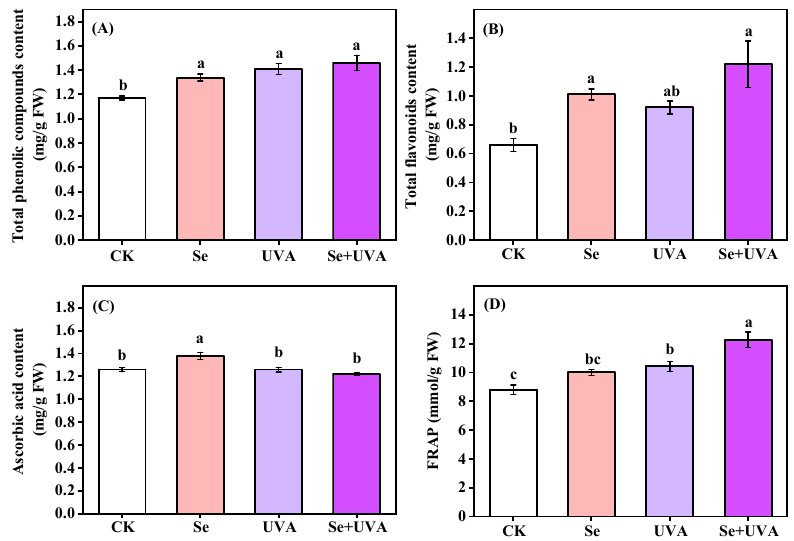
Figure 4. The contents of total phenolic compounds ( A ), total flavonoids ( B ), ascorbic acid ( C ), and FRAP ( D ) in broccoli microgreens under Se (100 μ mol/L Na 2 SeO 3 ), UVA (40 μ mol/m 2 /s), and combined treatments. The vertical bars indicated standard errors, n = 3. Different lower-case letters above the bars indicated significant differences between treatments by Duncan’s multiple range test at a level of 0.05. Table 4. The interaction effects of Se and UVA on antioxidant content and capacity of broccoli